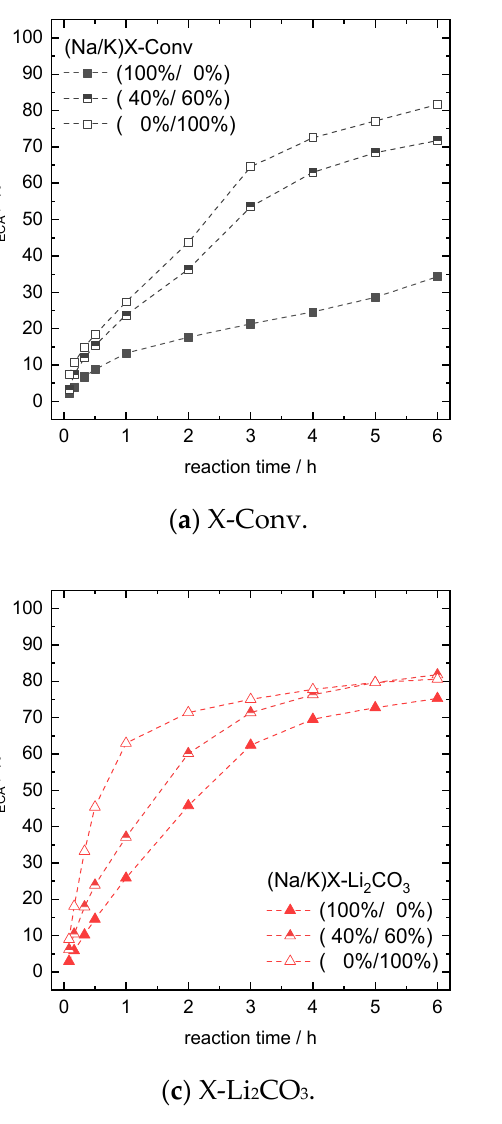
Figure 7. Conversion of ethyl cyanoacetate (ECA) in Knoevenagel condensation with benzaldehyde over time for all four zeolite X morphologies: X-Conv ( a ), X-Addfree ( b ), X-Li 2 CO 3 ( c ), and X-TPOAC ( d ) with varying amounts of Na + and K + (as-synthesised NaX with 100% Na content, partially ion-exchanged NaKX after the first ion-exchange step and almost completely exchanged KX after the sixth ion-exchange step).